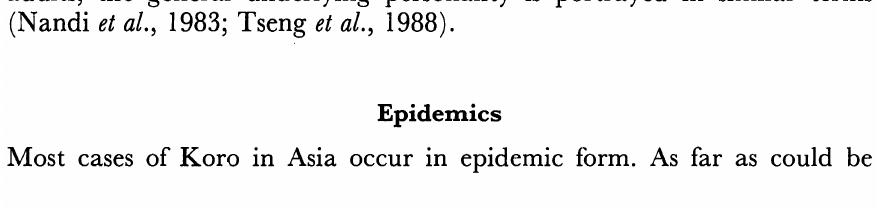
TABLE 1. Epidemics of